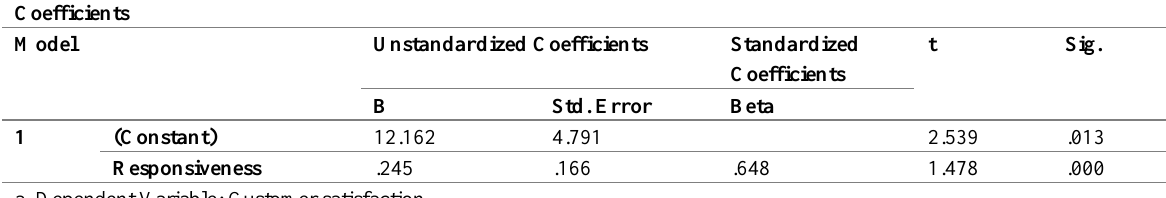
Table 11: Hypothesis Test Results of The Relationship Between Responsiveness and Customer